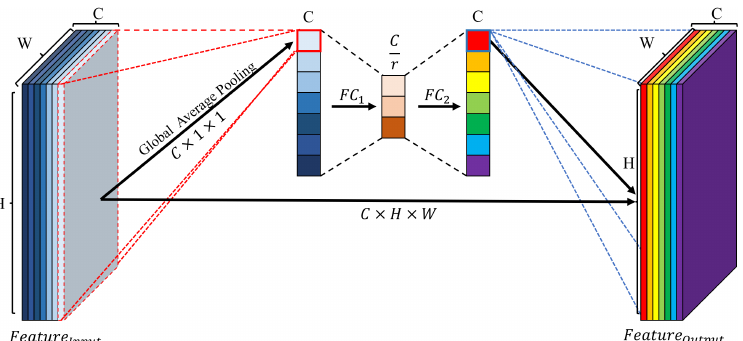
Figure 3. Architecture of channel attention. Channel attention compresses and readjusts the channels, attention to the features of each channel. where C, H, W and r denote the channel, height, width and channel reduction ratio,